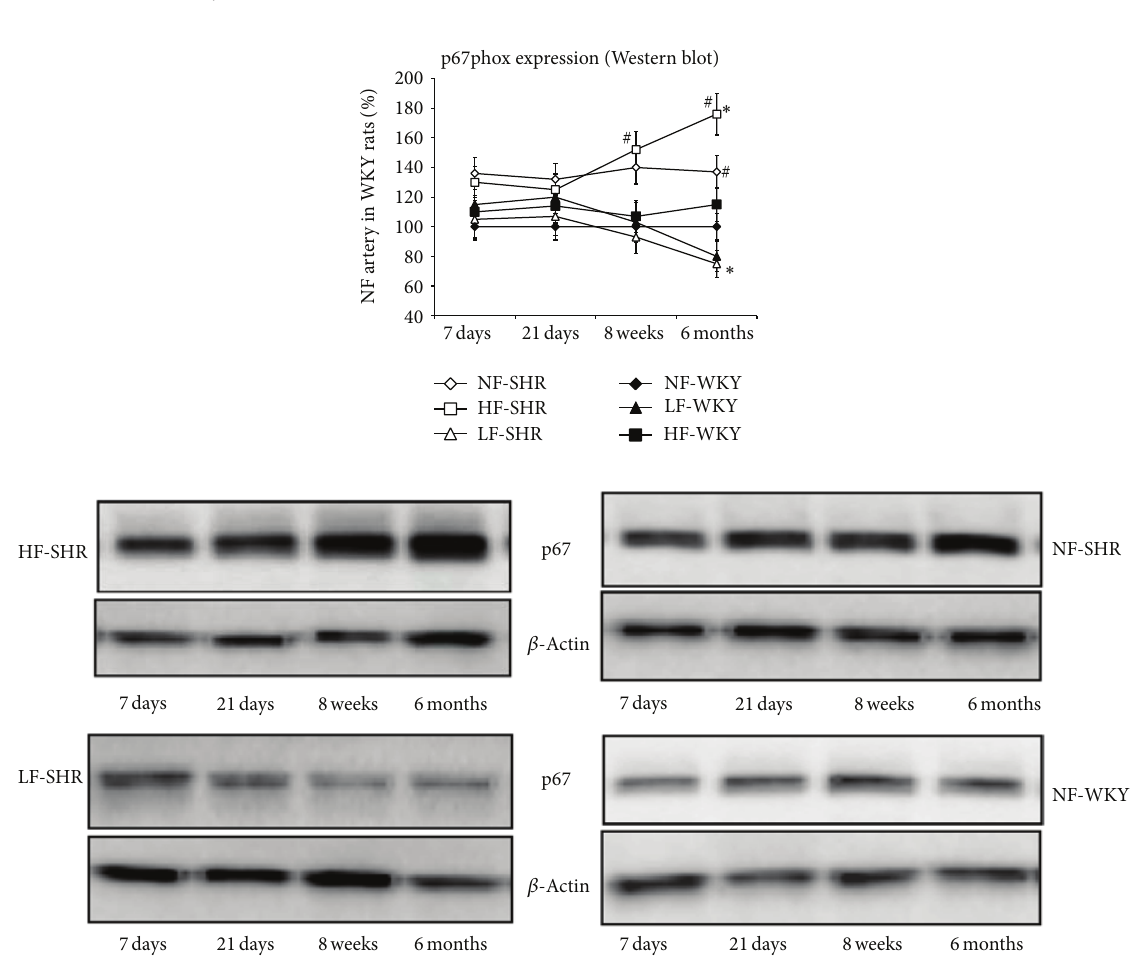
Figure 7: The NAD(P)H oxidase subunit p67phox expression level was determined using western blot in mesenteric resistance arteries isolated from WKY rats and SHRs submitted to low flow (LF), high flow (HF), or normal flow (NF) for 1, 3, 8, or 24 weeks. Values represent mean ± SEM ( 𝑛 = 12 rats per group). ∗ 𝑃 < 0.01 , HF or LF versus NF arteries. # 𝑃 < 0.05 , SHRs versus WKY rats, within equivalent arteries (NF, LF, or HF).